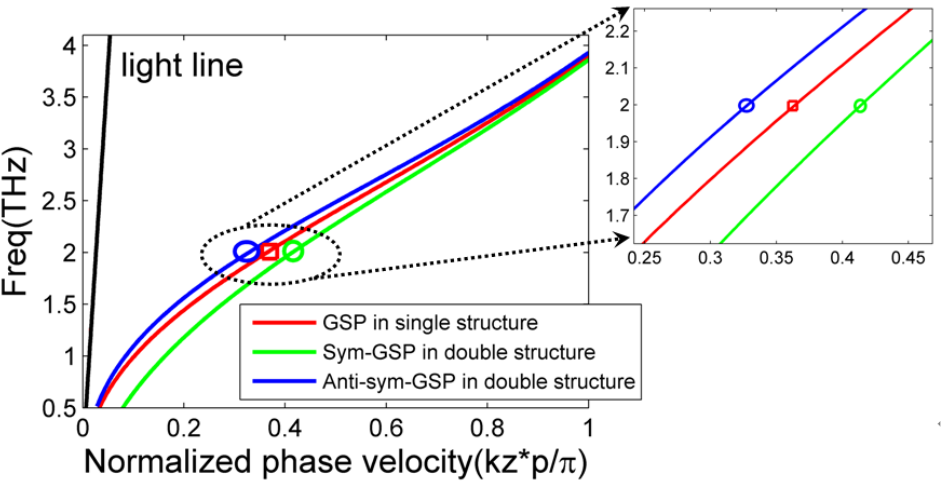
Figure 2. Dispersion diagrams of the GSP mode on the single- ( red line ) and double-layer ( blue and green line ) graphene metasurfaces. For graphene metasurface, its width and period are 0.5 and 1 µ m, respectively. The gap size of bi-layer structure is g = 1 μm. Others are given in the text.